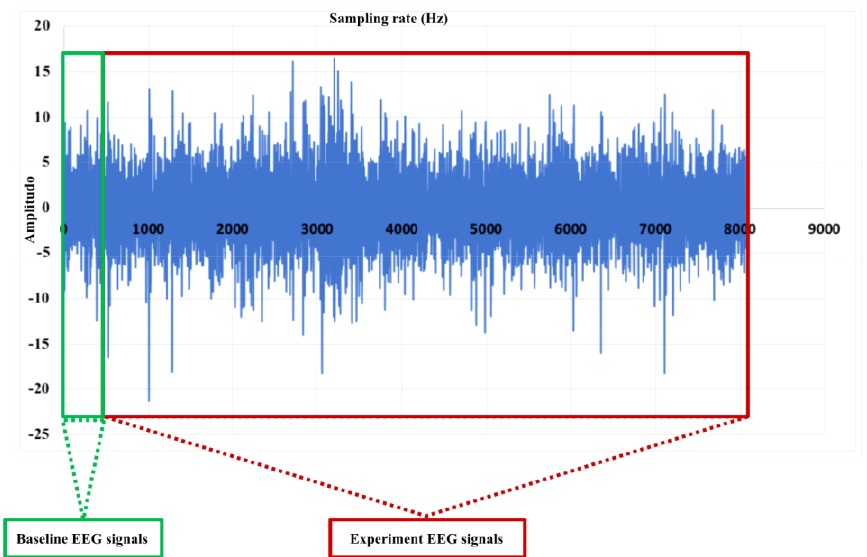
Figure 2. Raw EEG signals for Fp1 from the DEAP dataset [26]